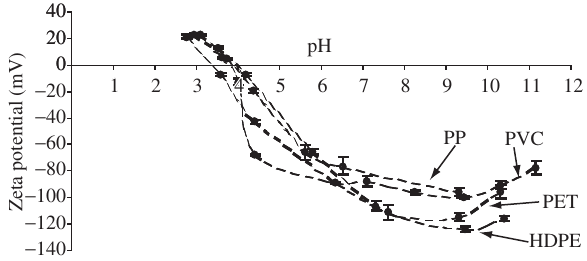
Figure 2. Zeta potential of planar surfaces of plastic materials.